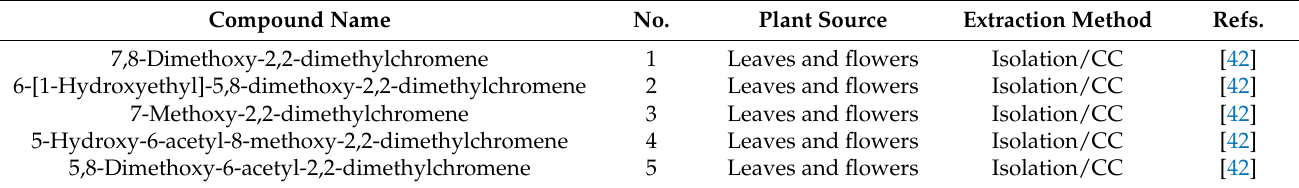
Table 1. Chemical constituents isolated from different parts of A. pichinchensis . Compound Name No. Plant Source Extraction Method